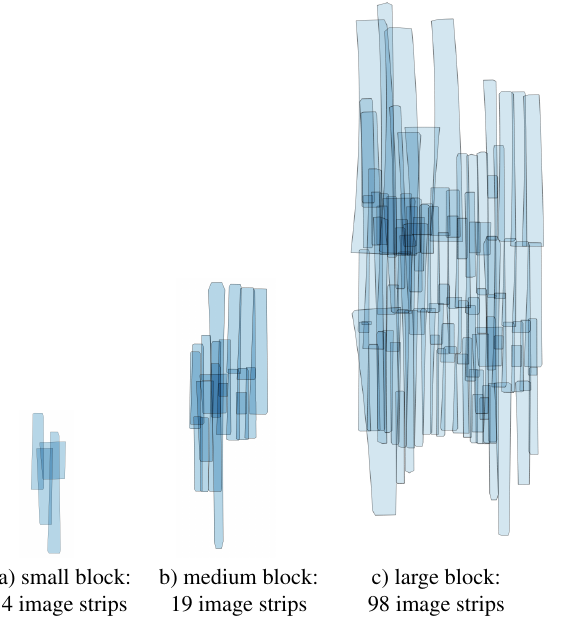
Figure 9: Nadir image footprints of HRSC strips, combined as blocks; a) same as Figure 4 for comparison sub-blocks is very high. This is caused by the fact that strips are chosen as primary strip more than once, and therefore, in these ar- eas the tie points are highly redundant. With an increasing size of the grid cells the number of selected tie points decreases, whereby the multi-strip sub-blocks led to about 20% less tie points.